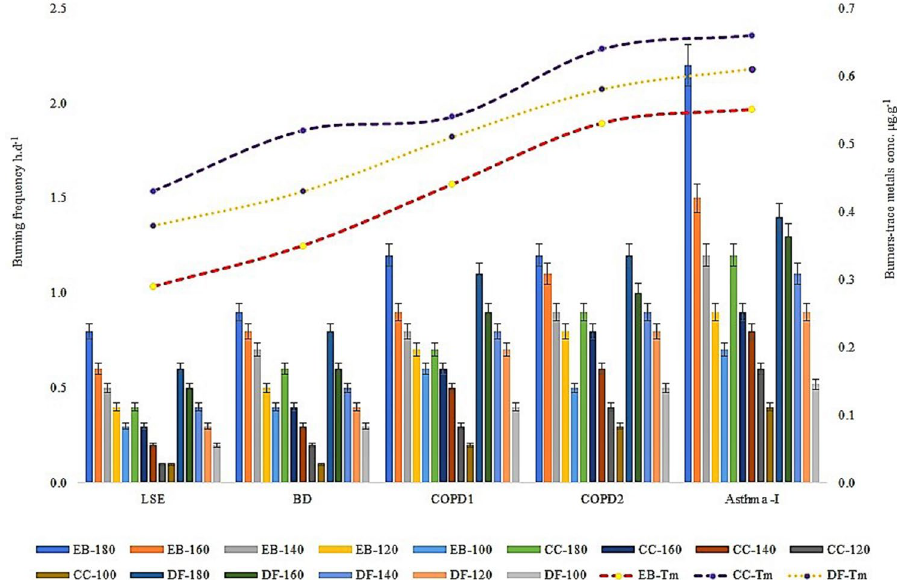
Figure 6. Effect of incense burners on room size, respiratory ailments, and trace metals concentrations. LSE low symptomatic effect; BD breathing difficulty, COPD1 chronic obstructive pulmonary disease (cough); COPD2 chronic obstructive pulmonary disease-(Emphysema), 100–180: area of room in ft2, EB electric burner, CC charcoal burner, DF direct flame, Tm trace